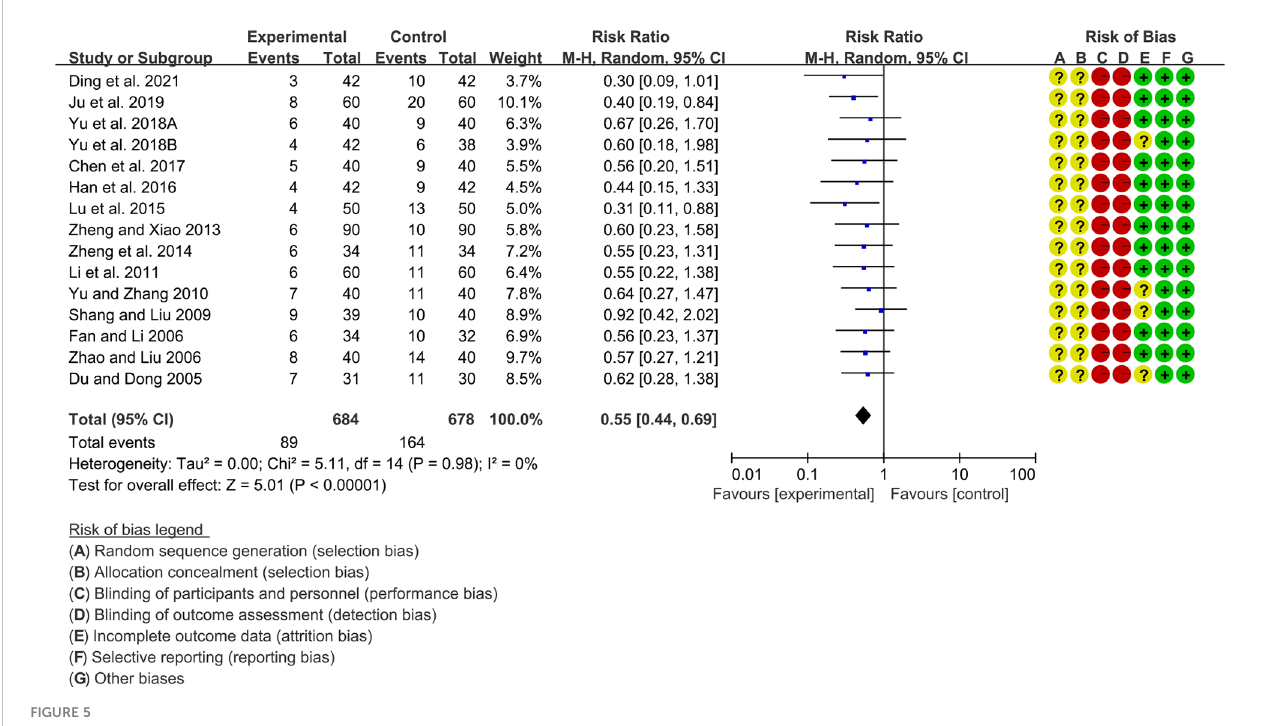
FIGURE 5 Adverse events in Total glucosides of paeony.